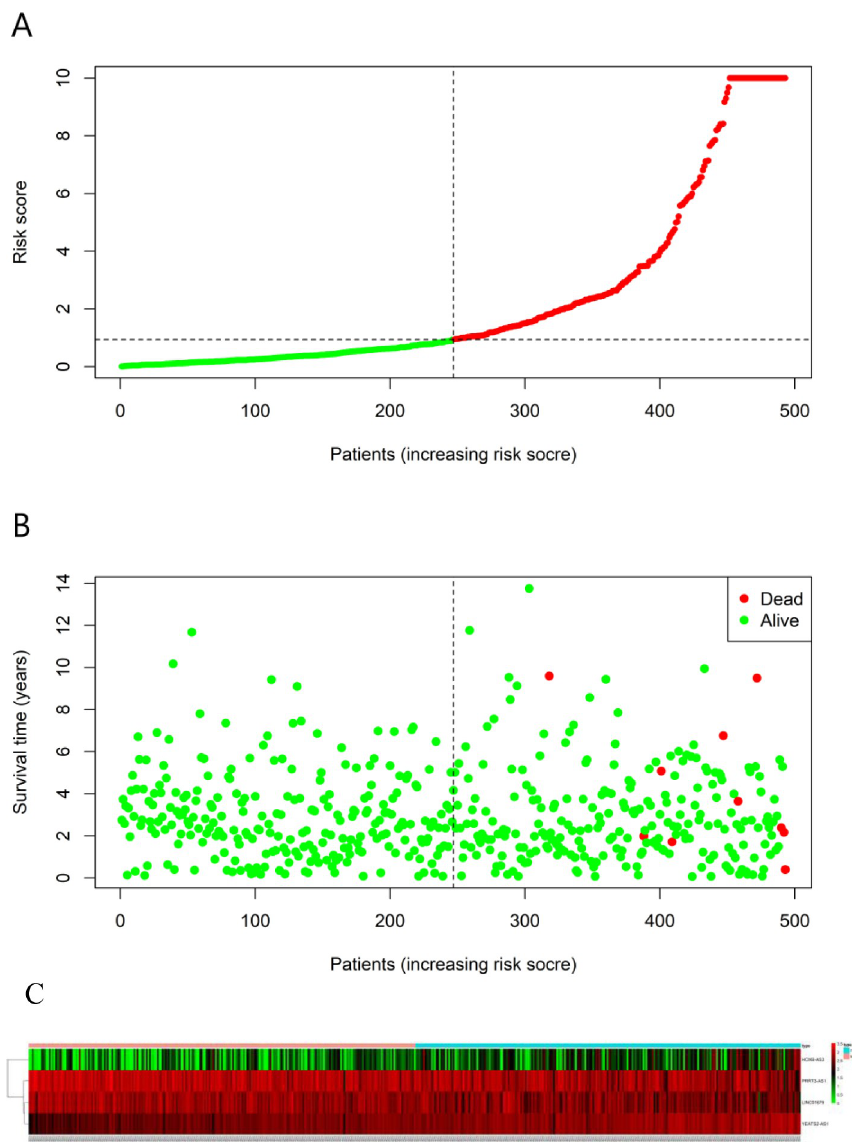
Fig 4. Ability of the 4 lncRNAs-based signature in predicting the prognosis for PCa cases from TCGA database. (A) Risk score distribution for patients. (B) PCa patient survival time. (C) Expression heat map for those four lncRNAs incorporated into the prognosis model. The vertical black dotted line stands for the optimum threshold to divide cases to high- or low-risk group.